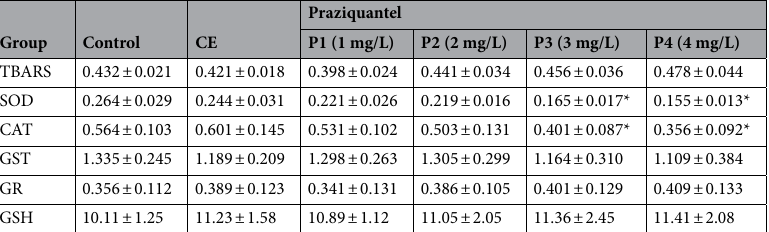
Table 4. jscsccb. The effect of praziquantel on oxidative stress biomarker (thiobarbituric acid reactive substances—TBARS, nmol/mg protein) and antioxidant enzymes (superoxide dismutase—SOD, nmol NBT/ min/mg protein; catalase—CAT, µmol H 2 O 2 /min/mg protein; glutathione S-transferase—GST, nmol/min/mg protein; glutathione reductase—GR, nmol NADPH/min/mg protein; reduced glutathione—GSH, nmol GSH/ mg protein) in the homogenate of carp. *Significantly ( P < 0.01) difference of experimental groups compared to the